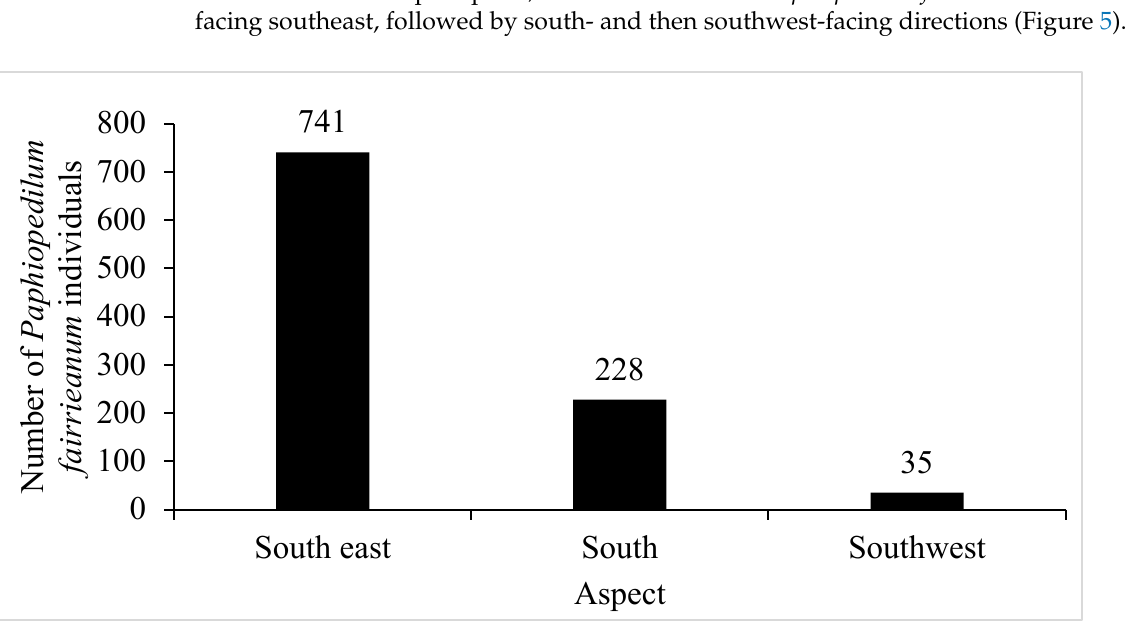
Figure 5. Abundance and distribution of Paphiopedilum fairrieanum with respect to slope aspect.